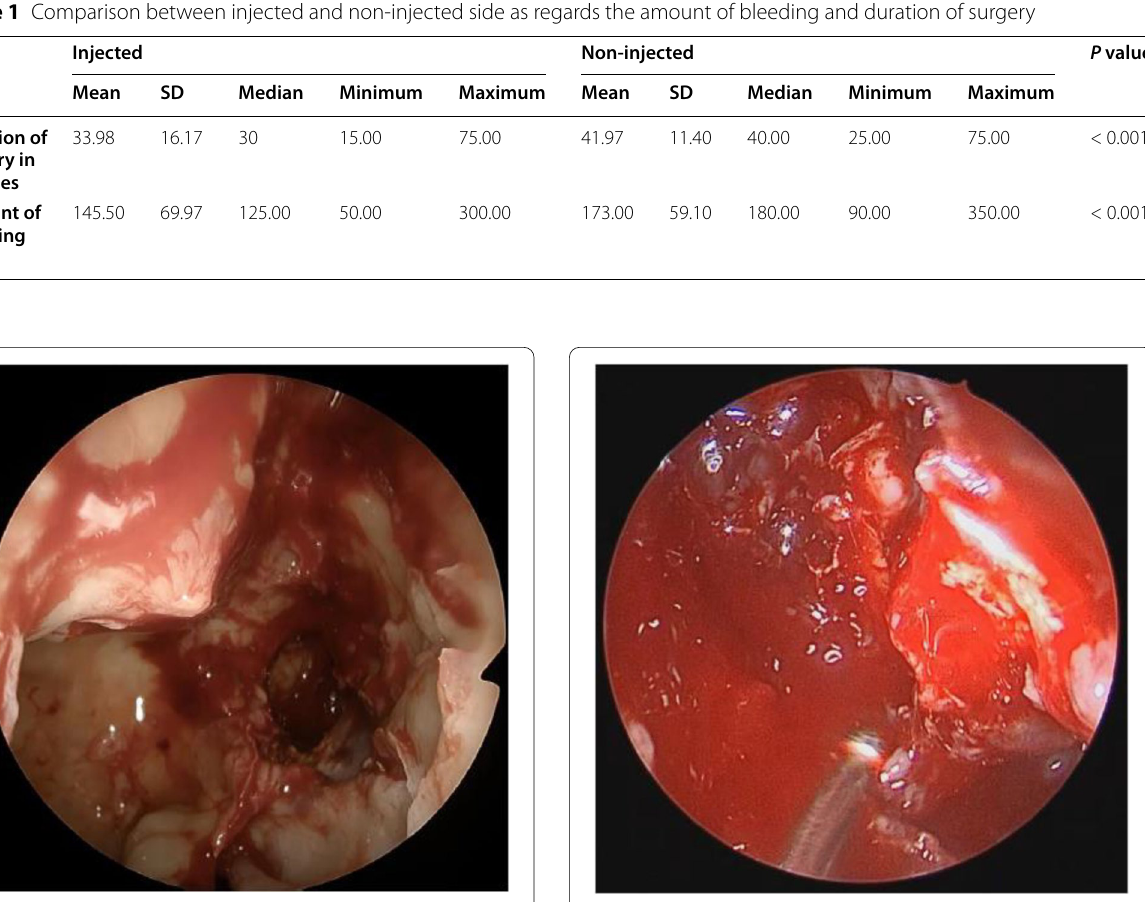
Fig. 4 Non‑injected left side shows more intraoperative